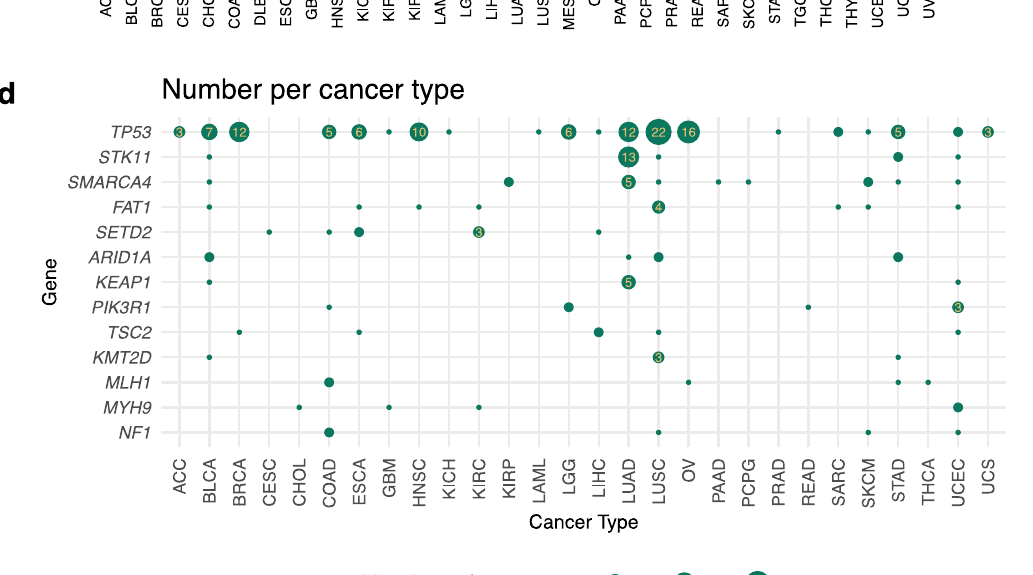
minimum values within 1.5×IQR from the edges of the box, respectively. For each IRAV, the Z -value comparing the ratios of intron retention between samples with the IRAV and other samples in the same cancer type group is computed. We observed that most of the Z -values were above the reasonable threshold (>2), strongly suggesting that most IRAVs certainly generate intron retention. The information, such as the sample size for each box, is provided in the Source Data fi le. d Landscape of IRAVs in frequently altered cancer-relatedgenes (totalnumber ≥ 5) across cancer types. The point size indicates the number of affected samples. Genes are sorted by the total number of IRAVs in all cancer types. See also Sup- plementary Fig.